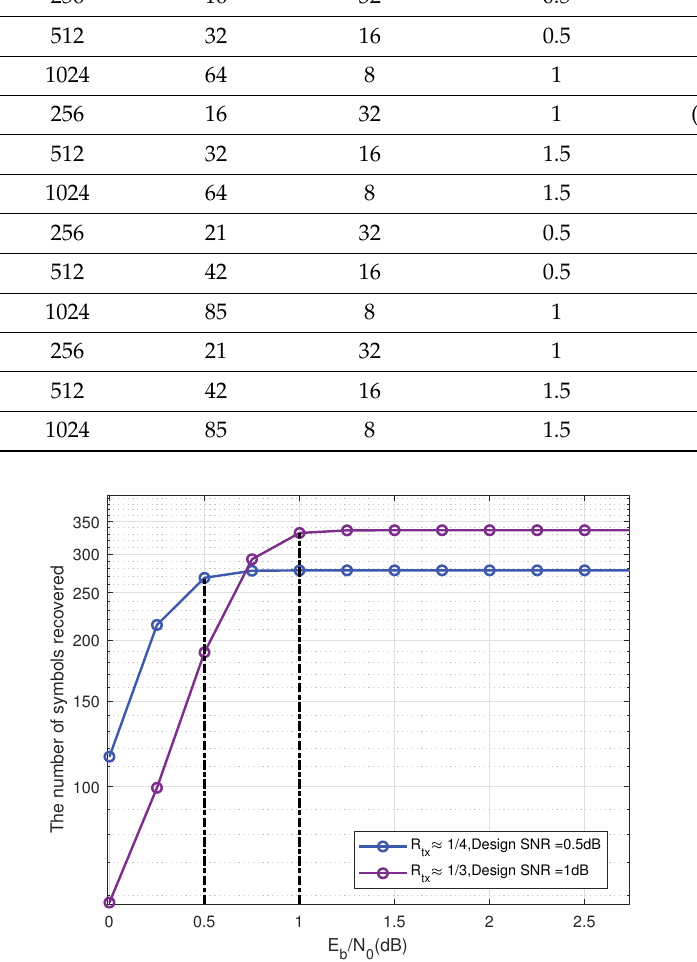
Figure 4. The impact of different SNRs on the number of symbols recovered, when S = 32, N = 256.